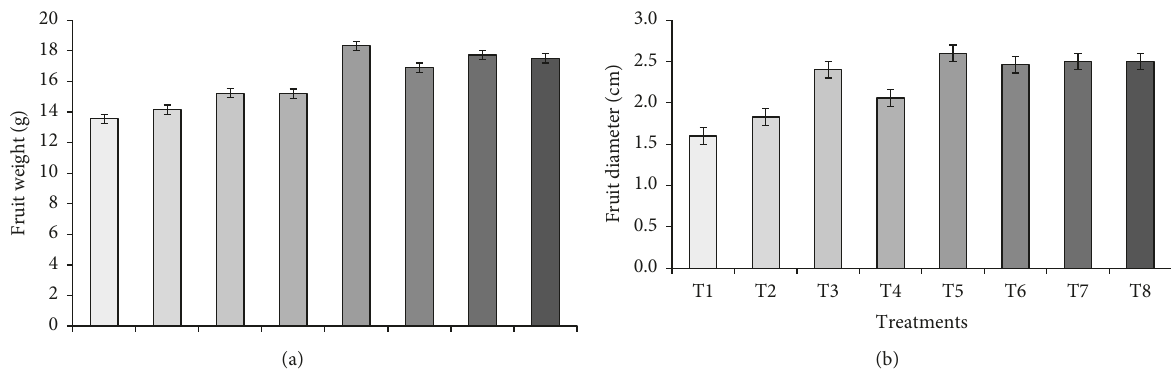
Figure 3: Influence of different organic and inorganic fertilizer regimes on (a) fruit weight (g) and (b) fruit diameter (cm) of strawberry cv. Chandler. T1: control; T2: urea 150kg N per ha; T3: FYM equivalent to 150kg N per ha; T4: PM equivalent to 150kg N per ha; T5: FYM equivalent to 75kg N per ha+ PM equivalent to 75kg N per ha; T6: FYM equivalent to 75 kg N per ha+urea equivalent to 75 kg N per ha; T7: PM equivalent to 75 kg N per ha+urea equivalent to 75kg N per ha; T8: FYM equivalent to 50 kg N per ha+PM equivalent to 50kg N per ha+urea 50kg N per ha.